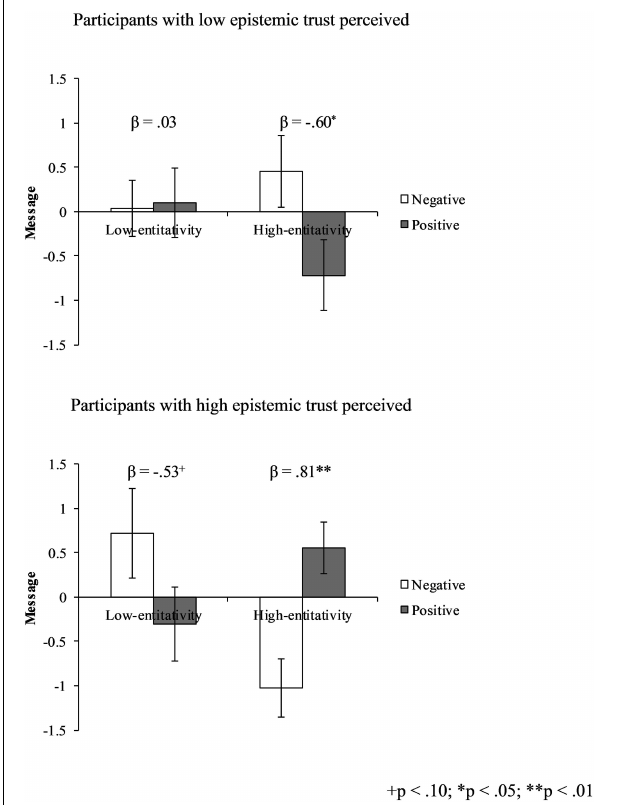
FIGURE 2 | Effect of audience attitude, audience group entitativity, and epistemic trust on